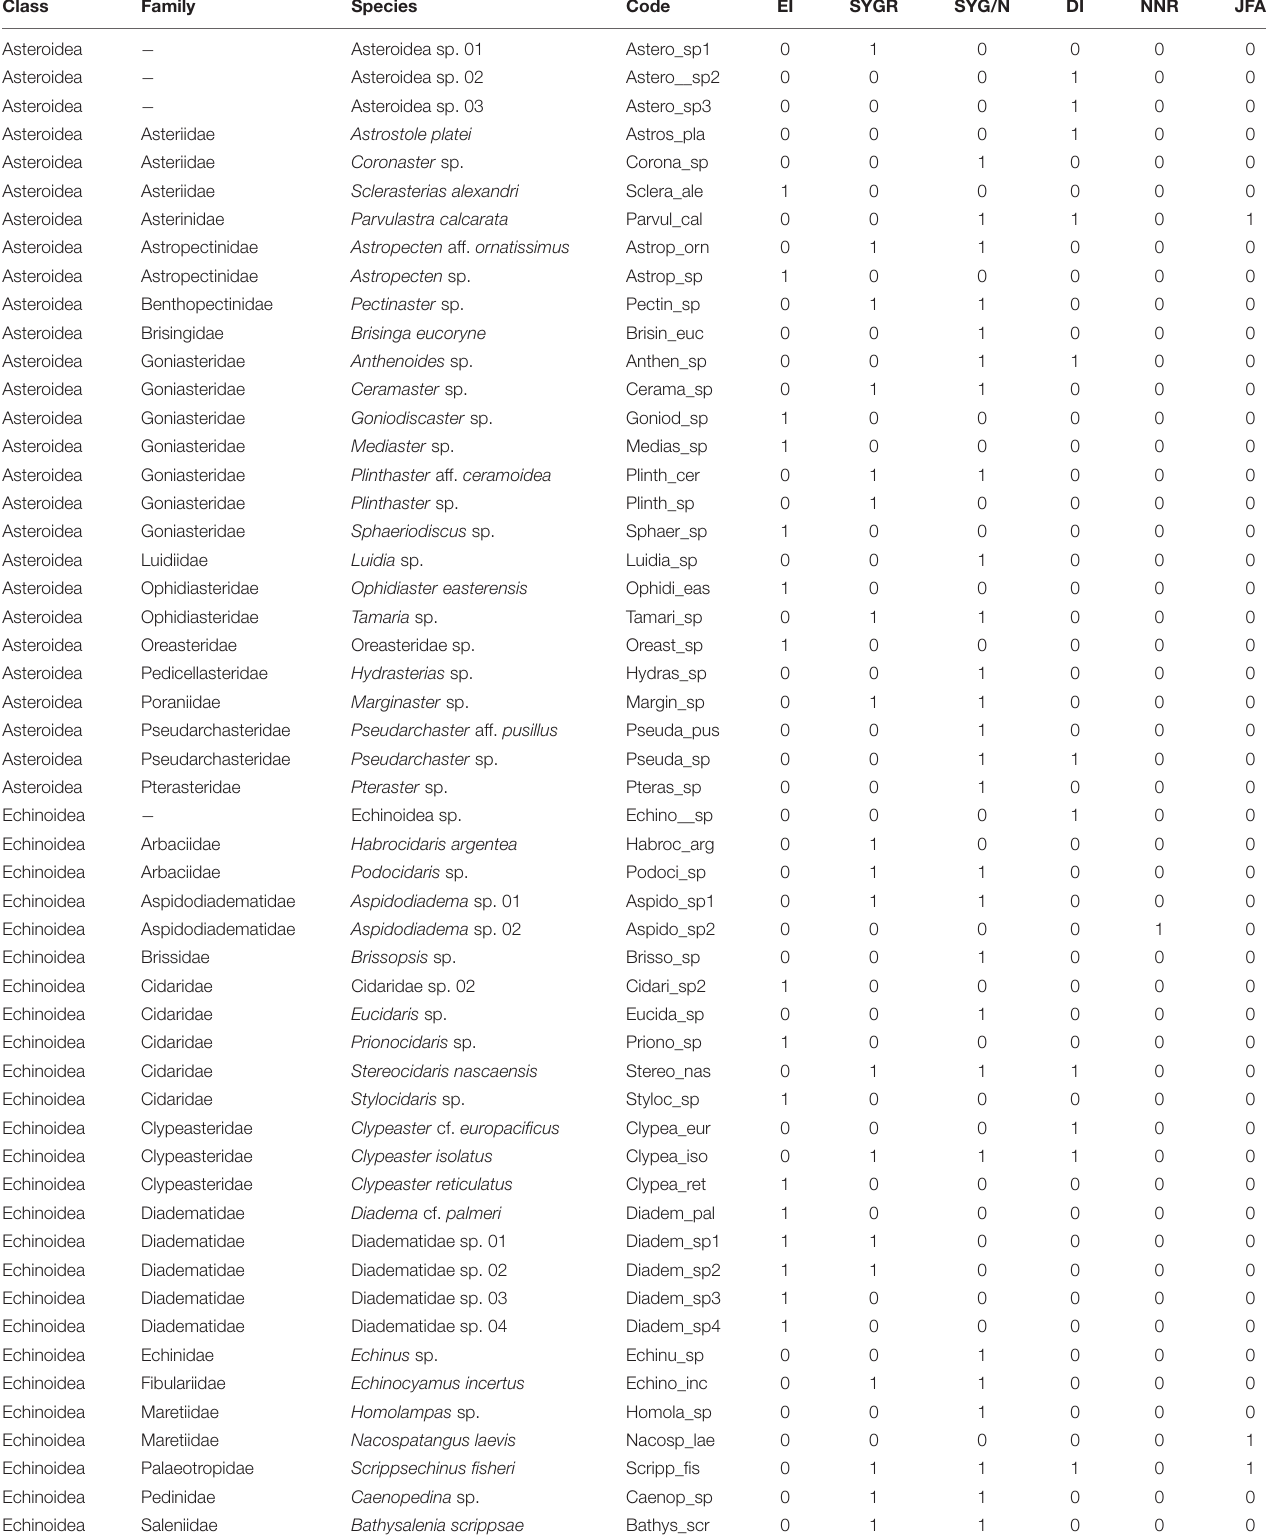
TABLE 2 | Faunistic groups of echinoderms considered in the present